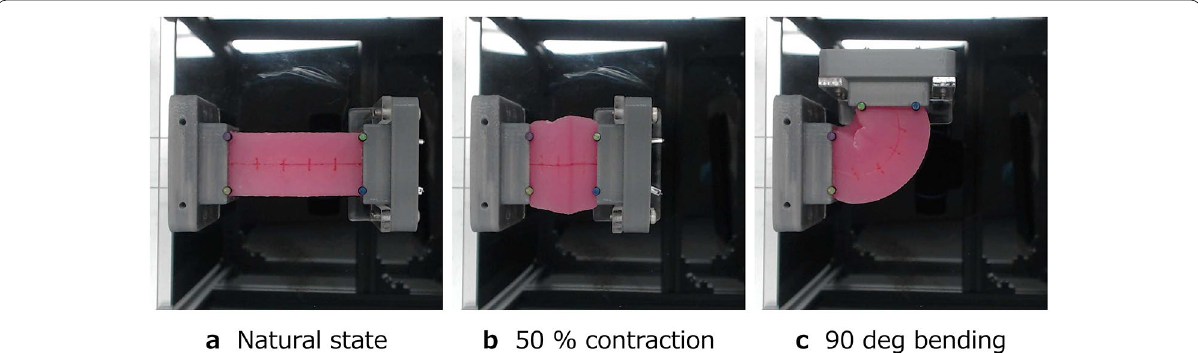
Fig. 3 Contraction and bending deformations of the prototype. The plasticizer mixing ratio is 100 wt%. The wire lengths l 1 and l 2 were adjusted manually so that the cap would be at the target position and angle, not by Eq.